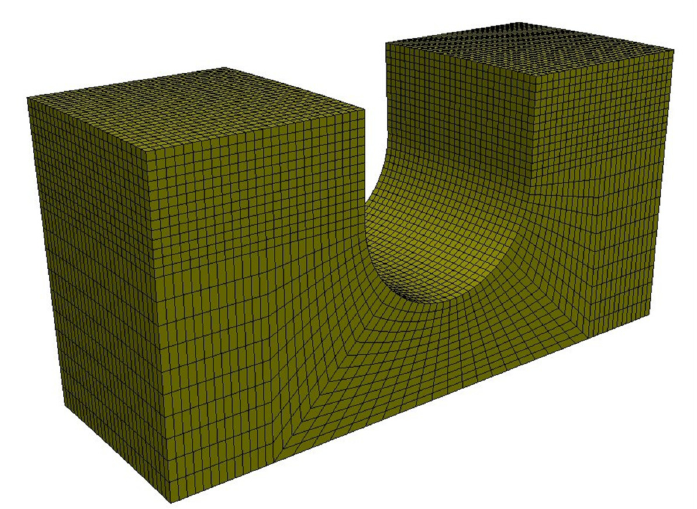
Figure 3: The grid around the notch tip.